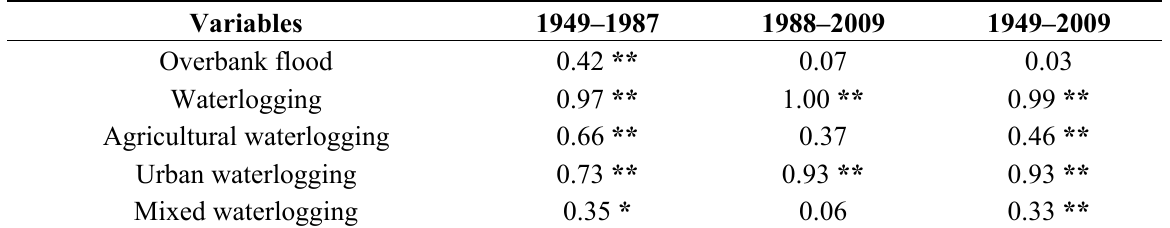
Table 3. Correlation coefficients between annual flood and subtype floods among the three